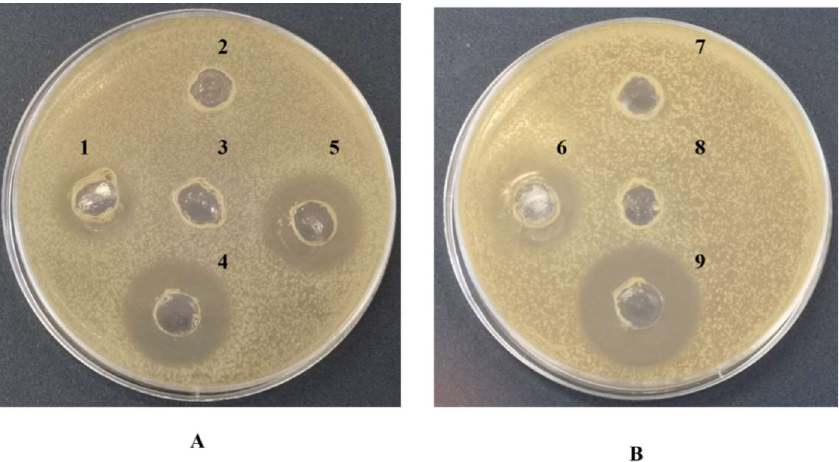
Figure 6. Sensitivity test of the purified biosurfactant from R . opacus R7 to proteinase K. Panel ( A ) shows the antimicrobial activity against E . coli ATCC 25922 of the purified biosurfactant treated the proteinase K (1), sterile milliQ water treated with proteinase K (2), sterile milliQ water not treated with proteinase K and not incubated (3), the purified biosurfactant not treated with proteinase K (4), the purified biosurfactant not treated with proteinase K incubated at 37 °C (5). Panel ( B ) shows the antimicrobial activity against S. aureus ATCC 6538 of the purified biosurfactant treated the proteinase K (6), sterile milliQ water treated with proteinase K (7), sterile milliQ water not treated with proteinase K and not incubated (8), the purified biosurfactant not treated with proteinase K (9).